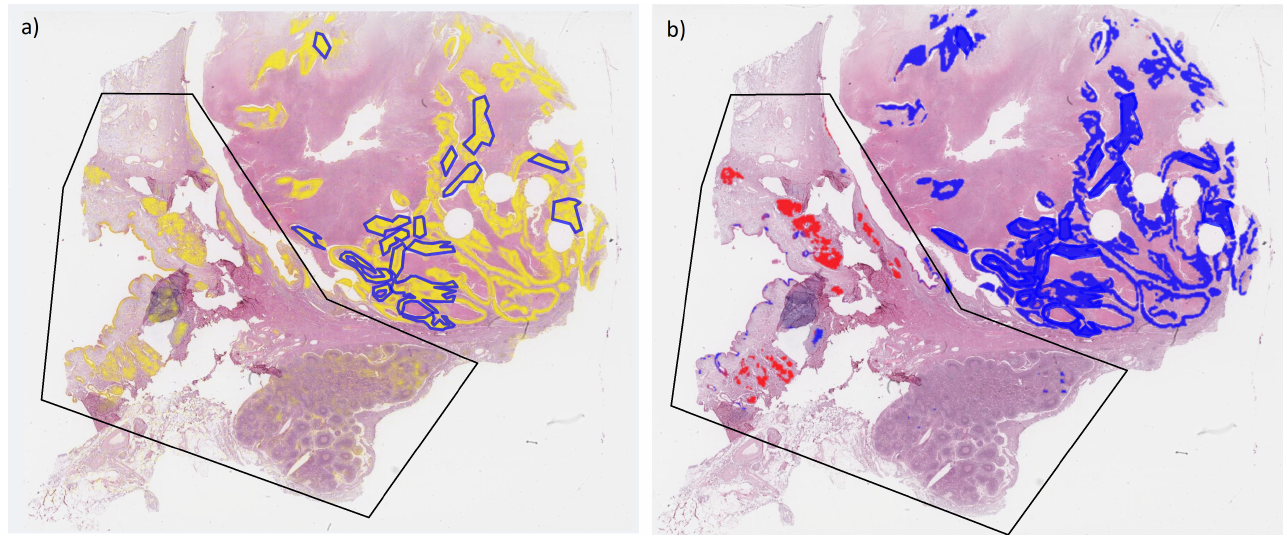
Figure 4. Whole slide image of test section SqCC9 overlaid with original annotations of tumor areas (blue lines). ( a ) Heatmap of segmentation (Seg1, yellow filling) and ( b ) heatmap of tumor classification (blue filling: SqCC, red filling: ADC). Black polygon highlights area with normal tissue misclassified as